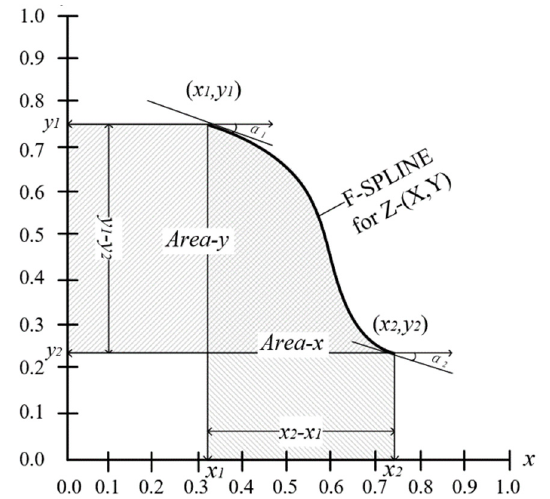
Figure 1. Shape parameters of